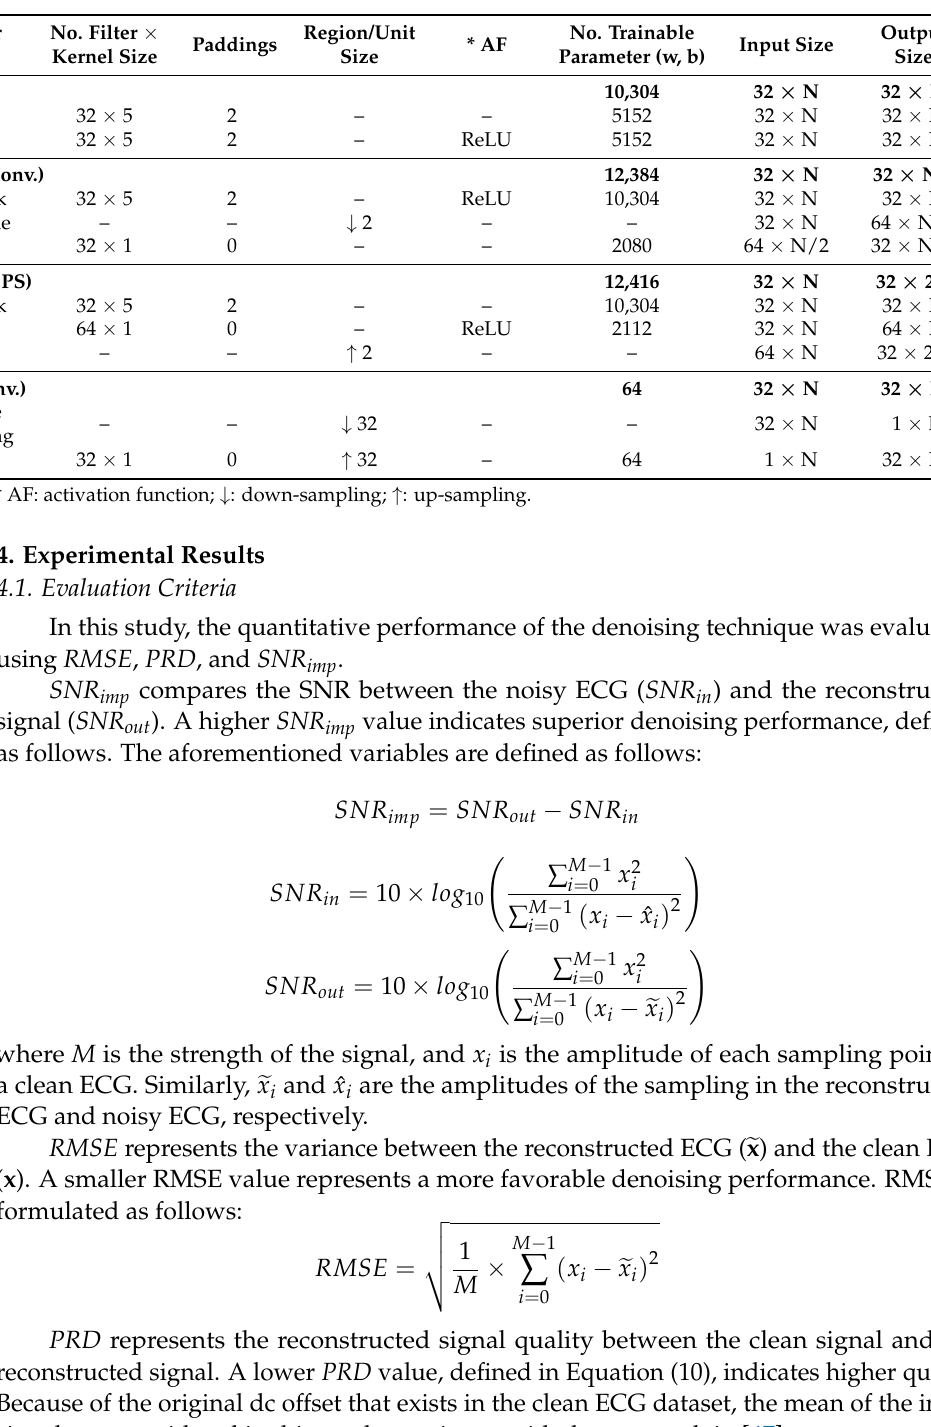
Table 3. Layer Information of the Submodule for the Regular Version of the Proposed